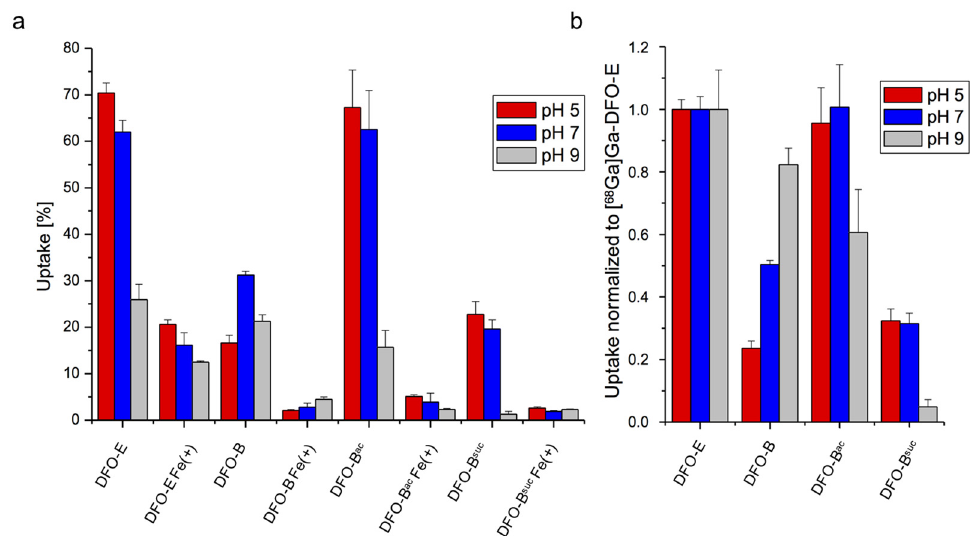
Figure 5. Short-term uptake efficacy of radiolabeled DFO-B depends on the ambient pH. Uptake of 68 Ga complexed by DFO-B and derivatives under iron limitation and sufficiency (Fe(+)) is shown ( a ) normalized to total siderophore activity and ( b ) normalized to [ 68 Ga]Ga-DFO-E uptake.